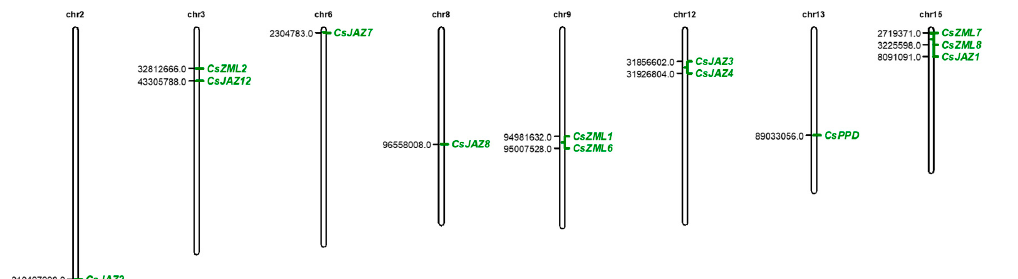
Figure 2. Chromosomal location of CsTIFY genes. A total of 13 CsTIFY genes were mapped to the eight chromosomes according to their positions in the tea plant genome. The chromosome number was shown on the top of each chromosome.